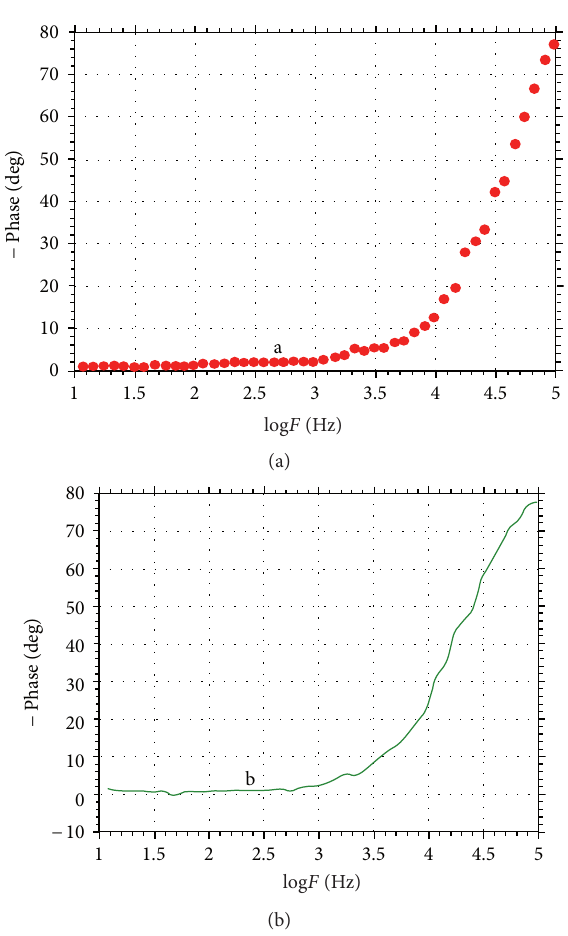
F 4: AC impedance spectra of carbon steel immersed in test solution (phase-Bode plot) (pH = 8). (a) Well water (blank). (b) Well water + DL-phenylalanine (150ppm) + Zn